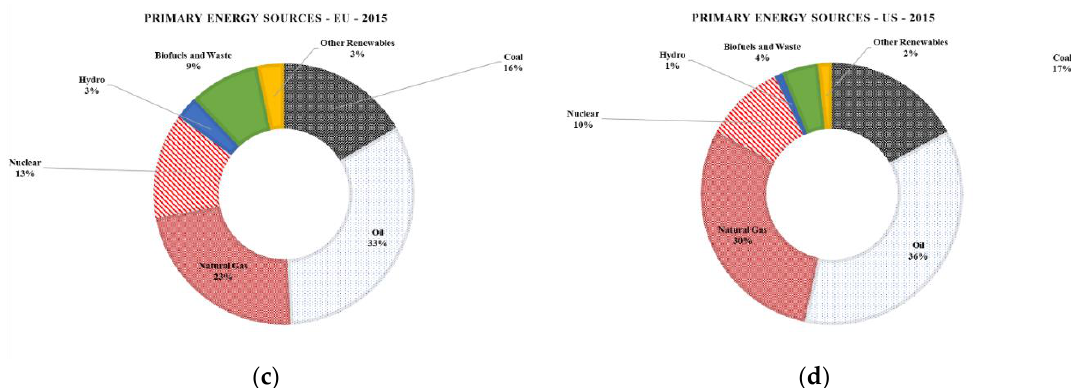
Figure 2. Primary energy resources for ( a ) Arab region, ( b ) World, ( c ) EU, and ( d ) US during 2015 (Source of the data: IEA [1]).